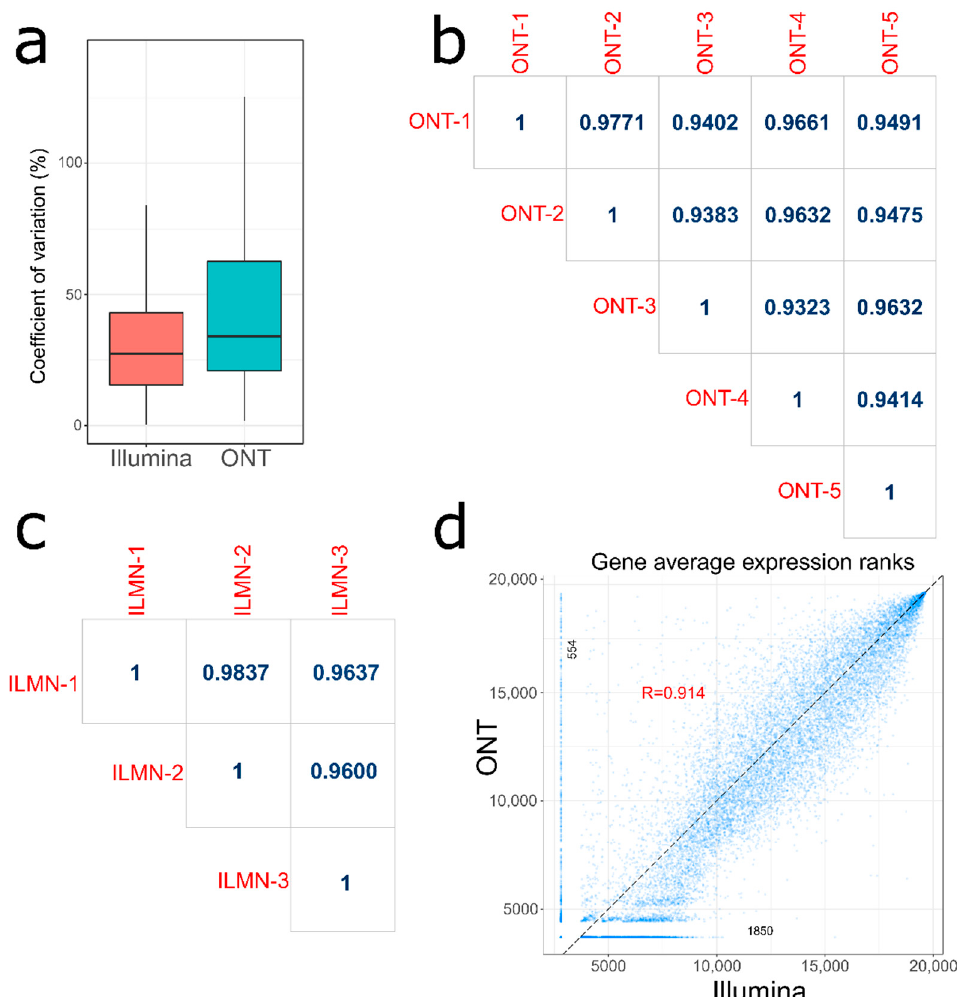
Figure 2. Comparison of intra- and inter-platform variation of gene quantification for Illumina and ONT. Data were restricted to genes that were observed in all replicates for each platform. Gene expression was measured in TPM units. ( a ) Distribution of coefficient of variation for both platforms. ( b ) Between replicates pairwise gene correlation matrix with Spearman coefficients for ONT platform. ( c ) Between replicates pairwise gene correlation matrix with Spearman coefficients for Illumina platform. ( d ) Correlation between average gene expression ranks for Illumina and ONT platform. Genes are represented by dots. Horizontal and vertical spurs indicate genes not detected by ONT ( n = 1850) and Illumina ( n = 554) platforms, respectively.